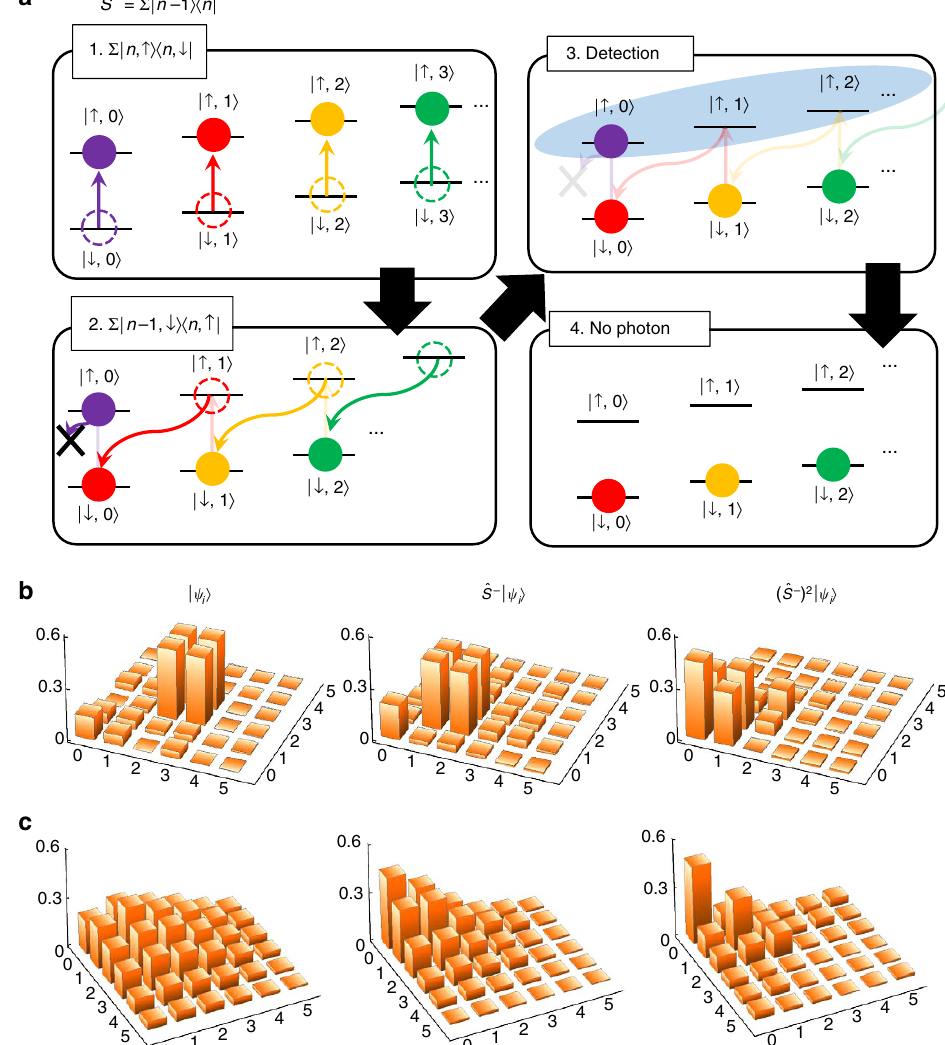
Figure 3 | Schematic diagram and experimental results of phonon subtraction. ( a ) Sequence of subtraction operations: the sequence of the operations for addition is reversed, that is, a p -pulse of carrier transition followed by a p -pulse of adiabatic blue-sideband transition. This takes the phonon state from i state is abandoned by the conditional measurement after the fluorescence p . The detection, which only collects non-zero phonon state data without fluorescence. ( b ) Subtraction on a superposition state c i j i¼ n ¼ 2 j iþ n ¼ 3 j ið Þ = ffiffiffi 2 population is reduced and the coherence is conserved. The initial fidelity and purity of the state are 0.83(0.02) and 0.73(0.03). The fidelities are changed to 0.77(0.02) and 0.83(0.01) after 1 and 2 times subtraction, respectively. The purities become 0.65(0.02) and 0.75(0.02). In the preparation and displacement operations for the superposition states with fluorescent detection, the zero components are increased due to unexpected experimental imperfections, which accidentally increase the fidelity and purity for the state 1 ffiffi p 0 j iþ 1 j ið Þ . ( c ) Subtraction from an initial coherent state a ¼ 1.2. The initial 2 fidelity of the state is 0.96(0.01) and the fidelities are reduced to 0.92(0.01) and 0.66(0.01) after 1 and 2 times subtraction,